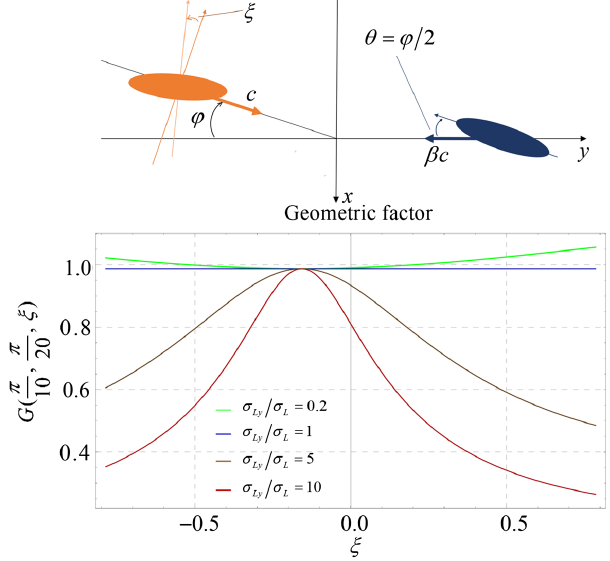
FIG. 7. Geometric factor G ð π = 10 ; π = 20 ; ξ Þ depending on the inclination angle of the laser pulse ξ for various ratios of its longitudinal and transversal sizes when colliding with an inclined electron